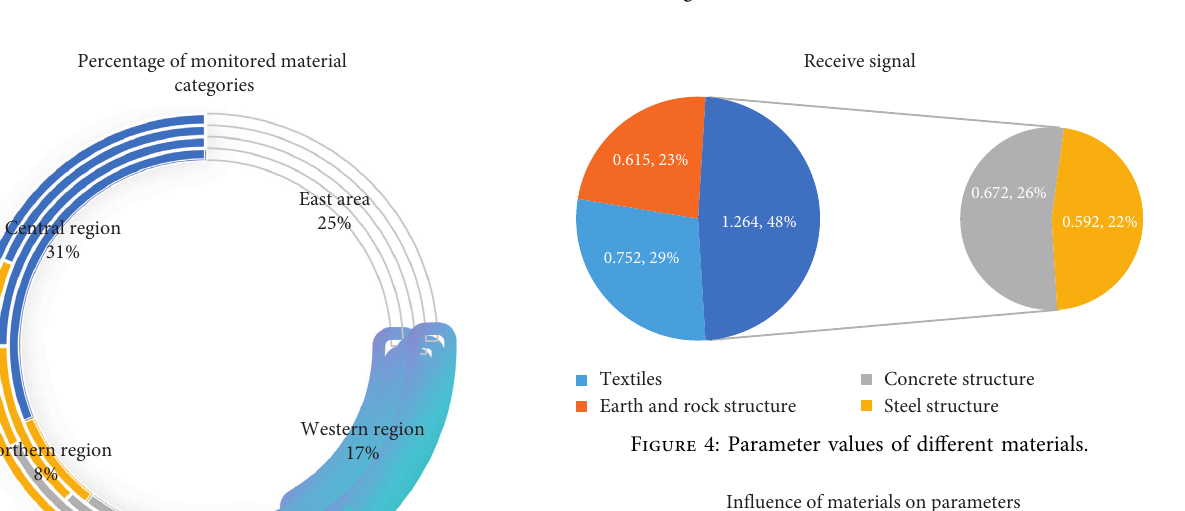
Figure 2: Distribution of health monitoring materials.